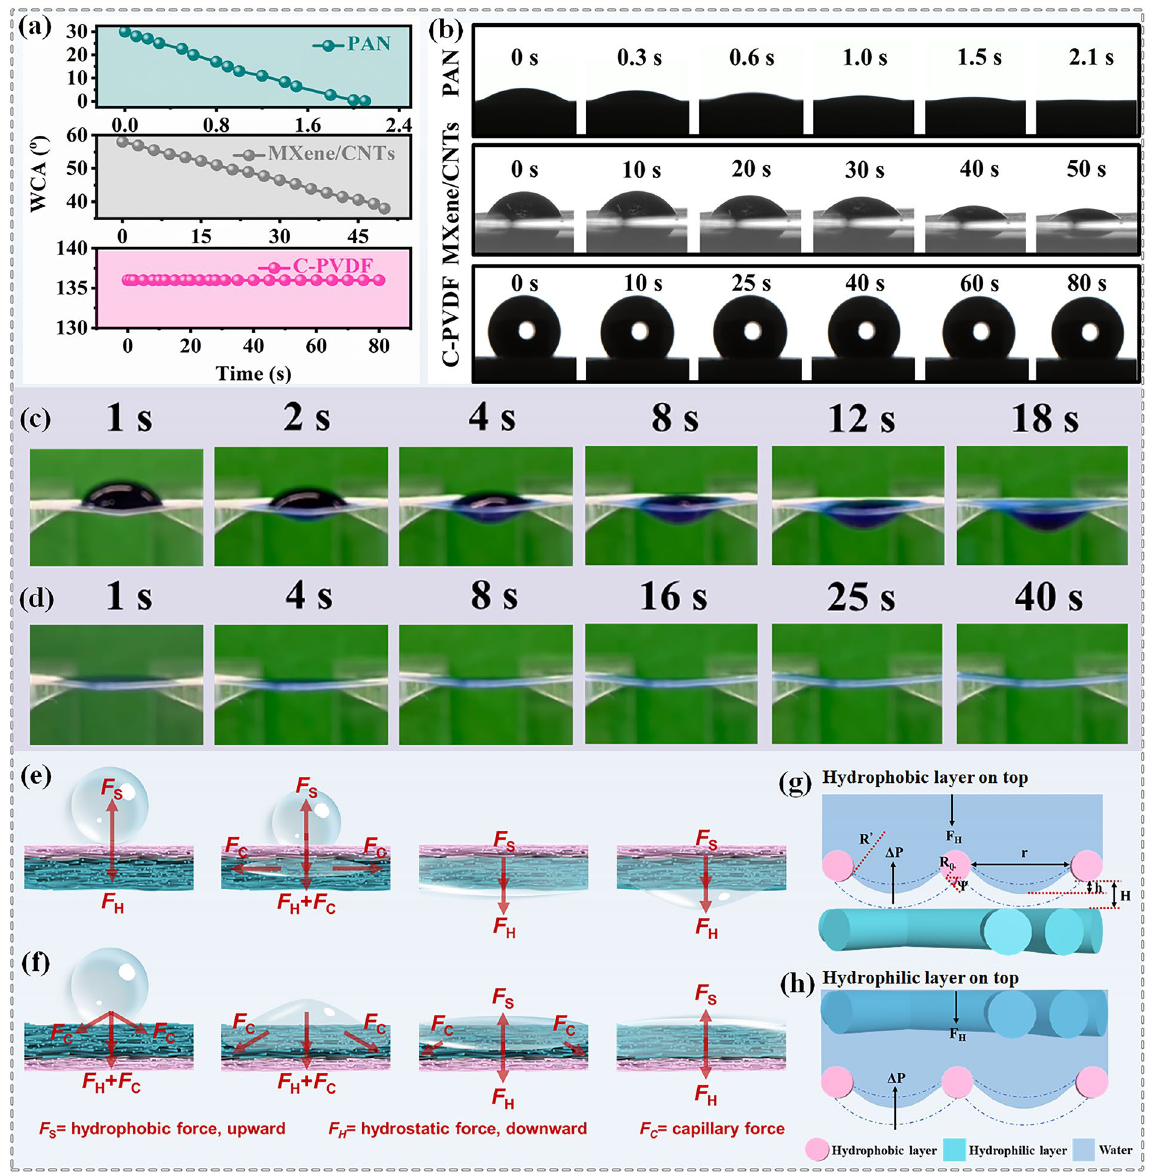
Fig. 3 The directional water transport properties of the DMWES. a, b Water contact angle change with time increasing. c Optical photographs of apparent contact angle change on the hydrophobic C-PVDF nanofibers. d Optical photographs of apparent contact angle change on the hydro- philic PAN nanofibers. e, f Proposed directional water transport mechanism of the DMWES form the hydrophobic and hydrophilic layer. g, h Proposed analysis model of the implementation of the directional water transfer in two